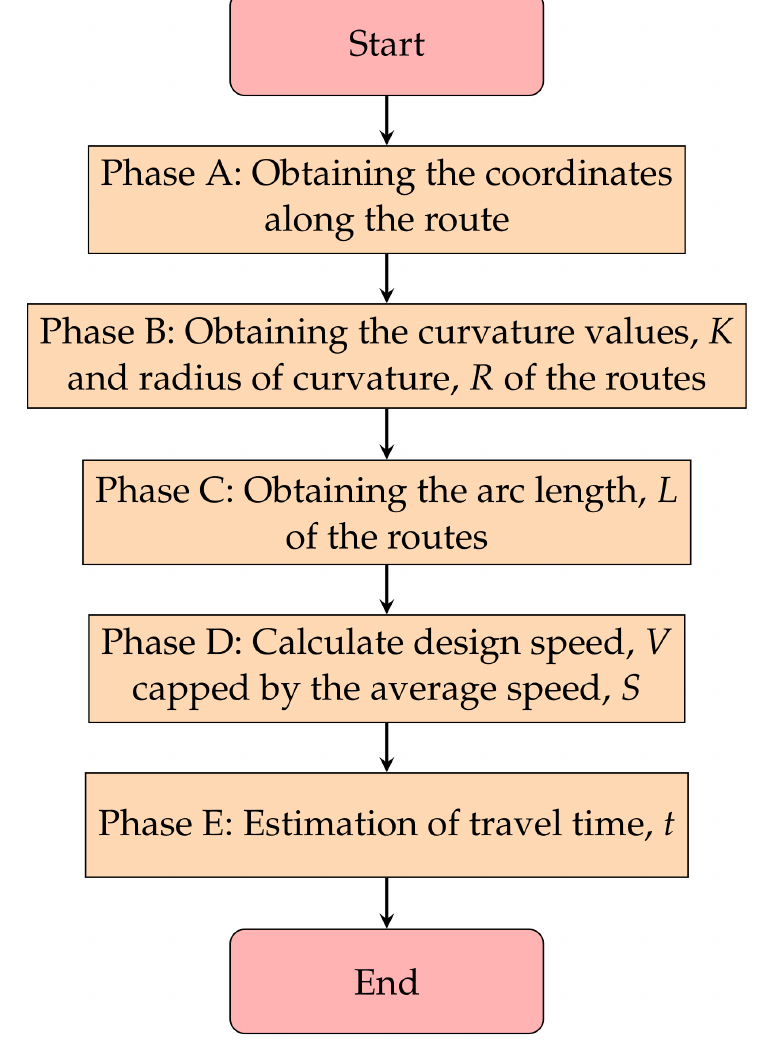
Figure 1. An overall flowchart of the proposed